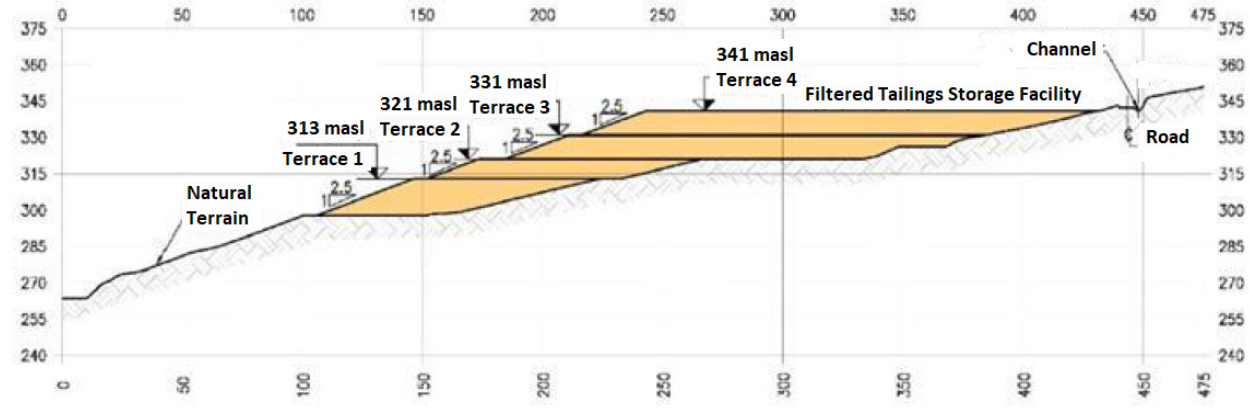
Figure 43. Tambo de Oro Filtered Tailings Storage Facility–Typical Cross Section [49].